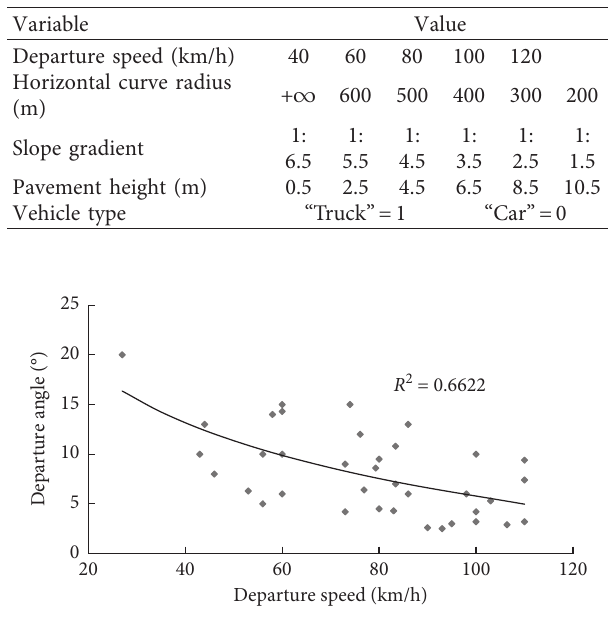
Figure 2: Relationship between departure speed and departure angle. Table 3: Departure